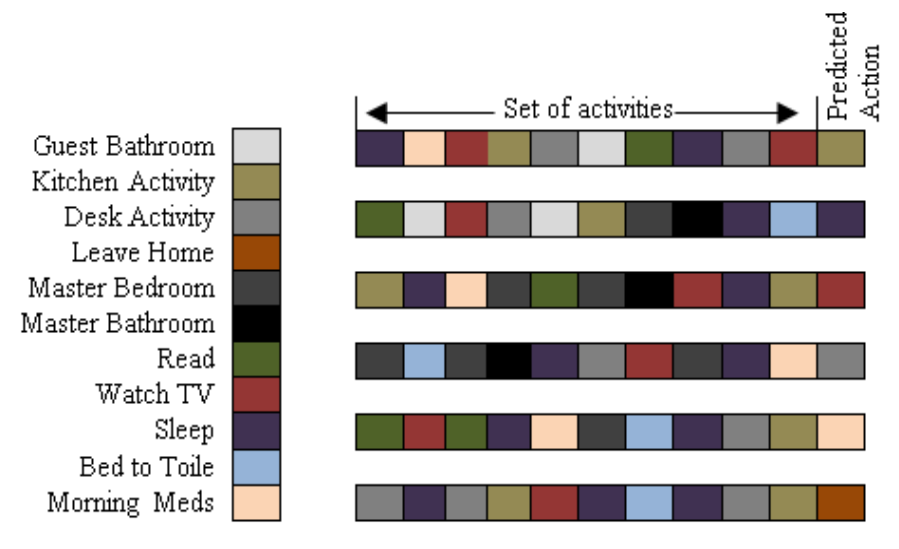
Figure 9. Behavioral predictions for